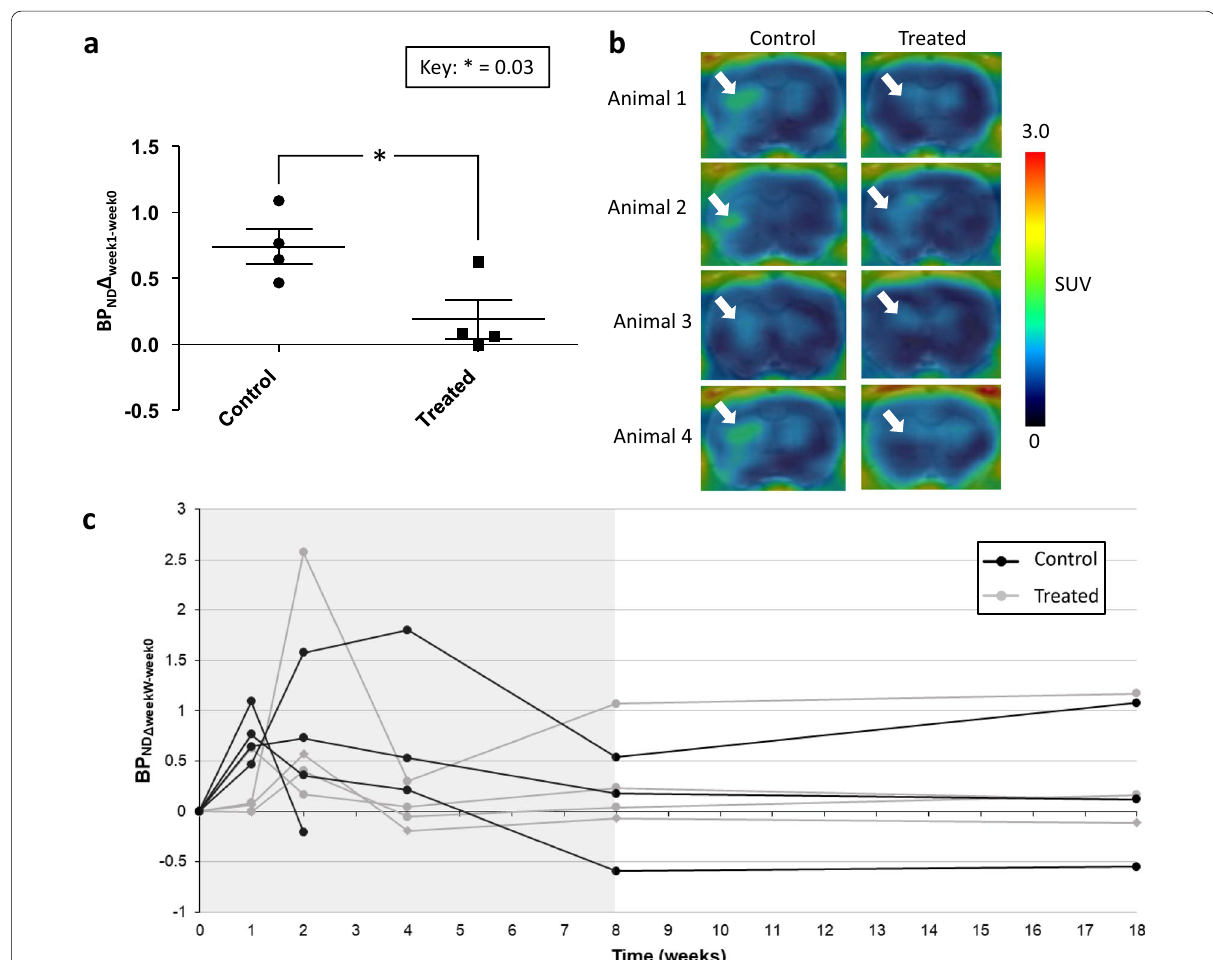
Fig. 3 Results from in vivo PET imaging. a Results from week 1 indicated a treatment effect of dimethyl fumarate (DMF). The binding potential (BP ND Δ week1‑week0 ) was calculated by reducing the BP ND of week 1 from the baseline image of an individual using a constant VOI for each animal for each time point. Statistics were calculated using the Student’s t‑test. The results are presented as mean (SD). Values in this figure represent the changes compared to baseline and not the original values to aid comparability of the BP ND between different individuals. However, the original values were applied in the statistical analyses. b Representative week 1 images. c Longitudinal in vivo imaging showed no differences between the control and DMF‑treated animals at any time point when analysed using a linear mixed model. Binding potential was calculated by first calculating: (BP ND ) (ipsilateral uptake contralateral uptake)/ contralateral uptake. After this, BP ND Δ weekW‑week0 was calculated by reducing the BP ND of the − specific week (W 1/2/4/8/18) from the baseline image of an individual using a constant VOI for each animal through the different time points. The = treatment period for Set A animals is indicated as grey background in the